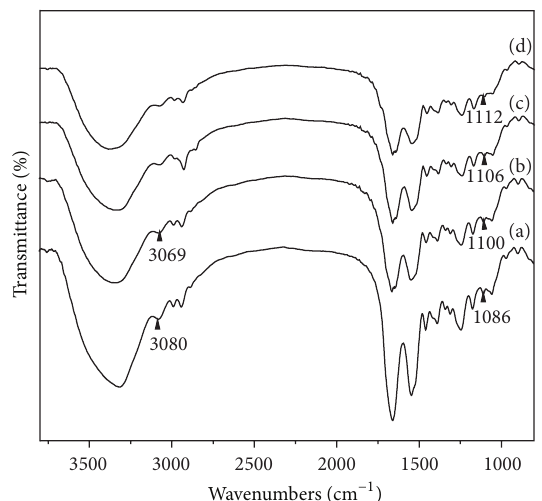
Figure 4: The FTIR spectra of the Ap -SF scaffolds (a) unmodified; (b)–(d) modified by 4, 10, and 20 wt.% succinic anhydride, respec- tively.